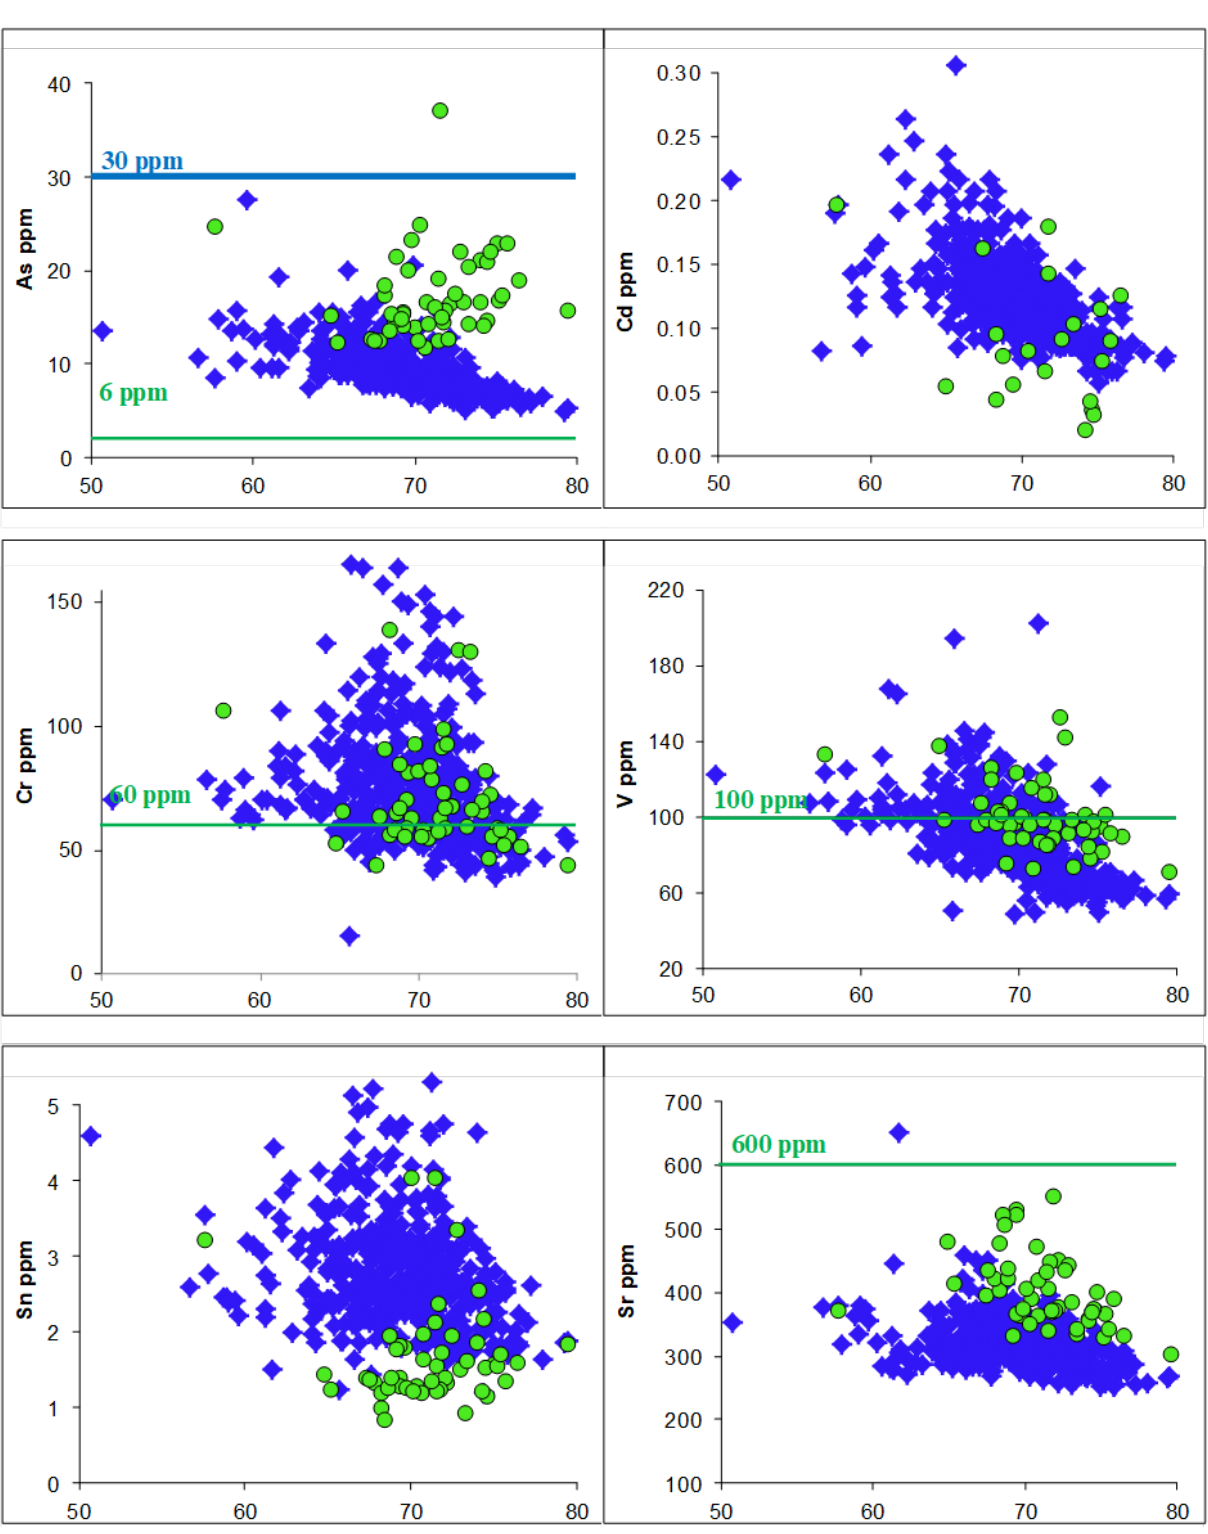
Fig. 4. Heavy metal contents vs SiO